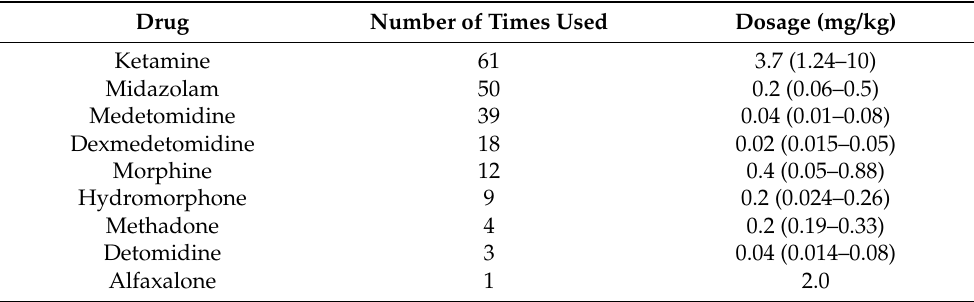
Table 1. Individual drugs used for immobilization of Galapagos ( Chelonoidis nigra) , Aldabra ( Aldabrachelys gigantea) , and African spurred tortoises ( Centrochelys sulcata) , including the num- ber of times each agent was administered out of 64 anesthetic events and the average dosage used (reported as mean with the range in